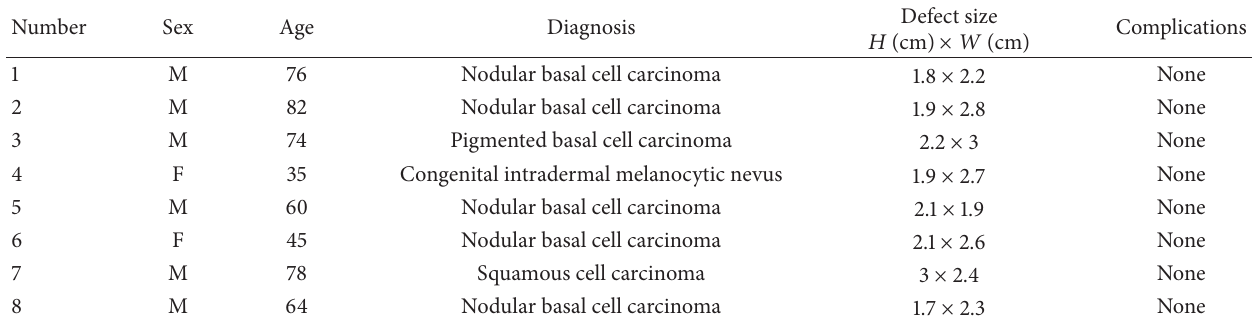
Table 1: Series of patients treated with a freestyle-like V-Y advancement flap for eyebrow